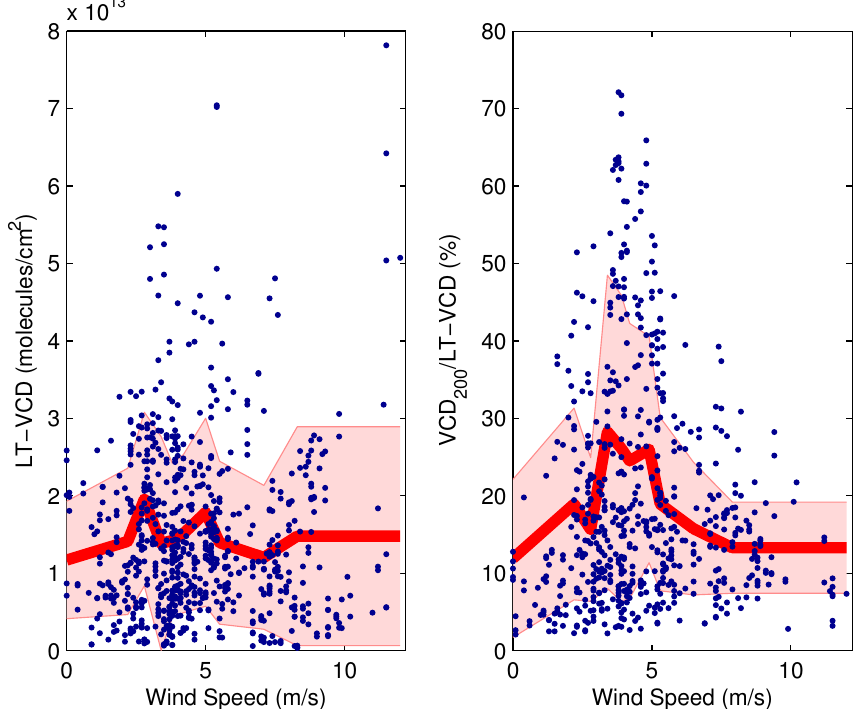
Figure 11. The left panel shows the relationship between the BrO LT-VCD and wind speed, while the right panel shows the percentage of BrO in the lowest 200m vs. the wind speed. In both cases, the red line represents the mean as a function of wind speed, calculated from deciles on the x axis, while the shaded region represents 1 standard